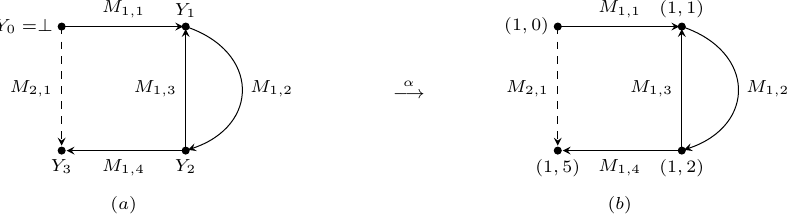
Figure 3: BINS graph BINstruct f (a) and the corresponding INS Graph INstruct f